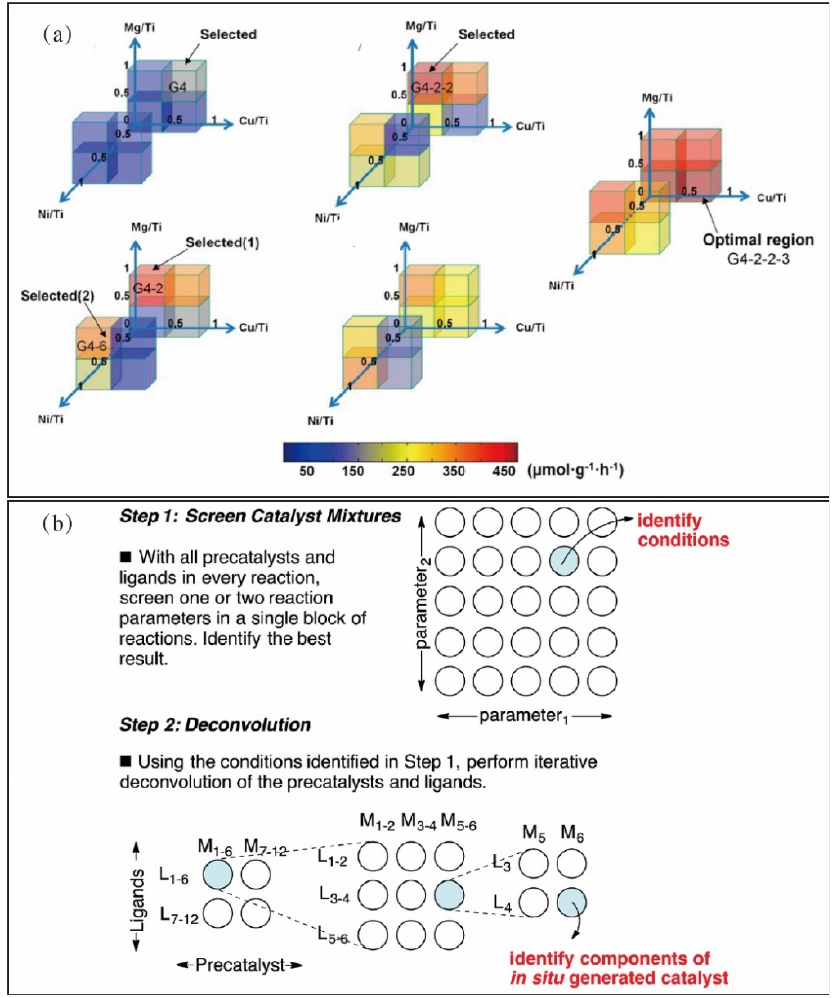
Figure 4. Experimental design for exploring the parameter space of catalysts. ( a ) Identification of the optimal active catalyst for hydrogen production by an ultrafast multidimensional group testing method. Reprinted with permission from Ref. [82]. Copyright 2012, American Chemical Society. ( b ) A combinatorial strategy for identifying lead “hits” in catalyst discovery by deconvolution of complex catalyst mixtures. Reprinted with permission from Ref. [84]. Copyright 2015, The Royal Society of Chemistry.